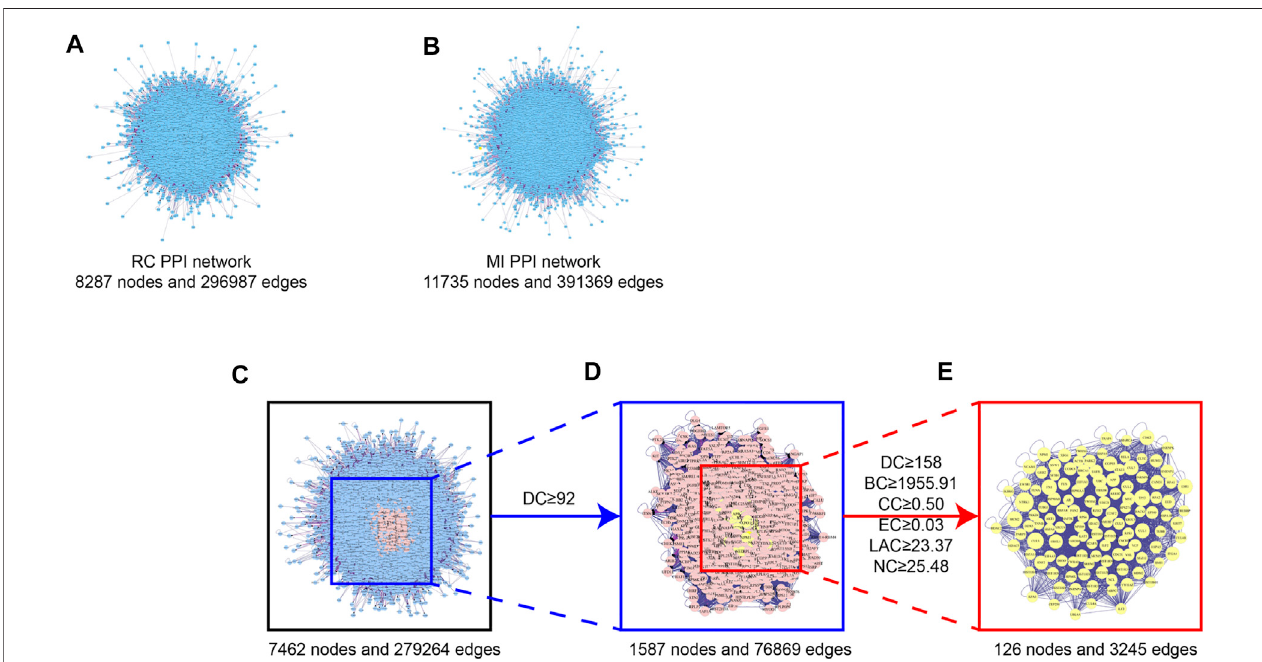
FIGURE 2 | Topological screening process of PPI network. (A) PPI network of the potential targets of the RC ingredients. 8,287 nodes represent the interactive proteins of RC, 2,96,987 edges represent the interactive relationship. (B) PPI network of the MI-related targets. 11,735 nodes represent the interactive proteins of MI, 3,91,369 edges represent the interactive relationship. (C) PPI network of merged RC and MI. 7,462 nodes represent the interactive proteins of the merged network, 2,79,264 edges represent the interactive relationship. (D) PPI network of merged RC and MI with DC ≥ 92. 1,587 nodes represent the interactive proteins of the mergednetworkwithDC ≥ 92,76,869edgesrepresenttheinteractiverelationship. (E) CentralPPInetworkofmergedRCandMI.126nodesrepresentthecoreproteins of the merged network, 3,245 edges represent the interactive